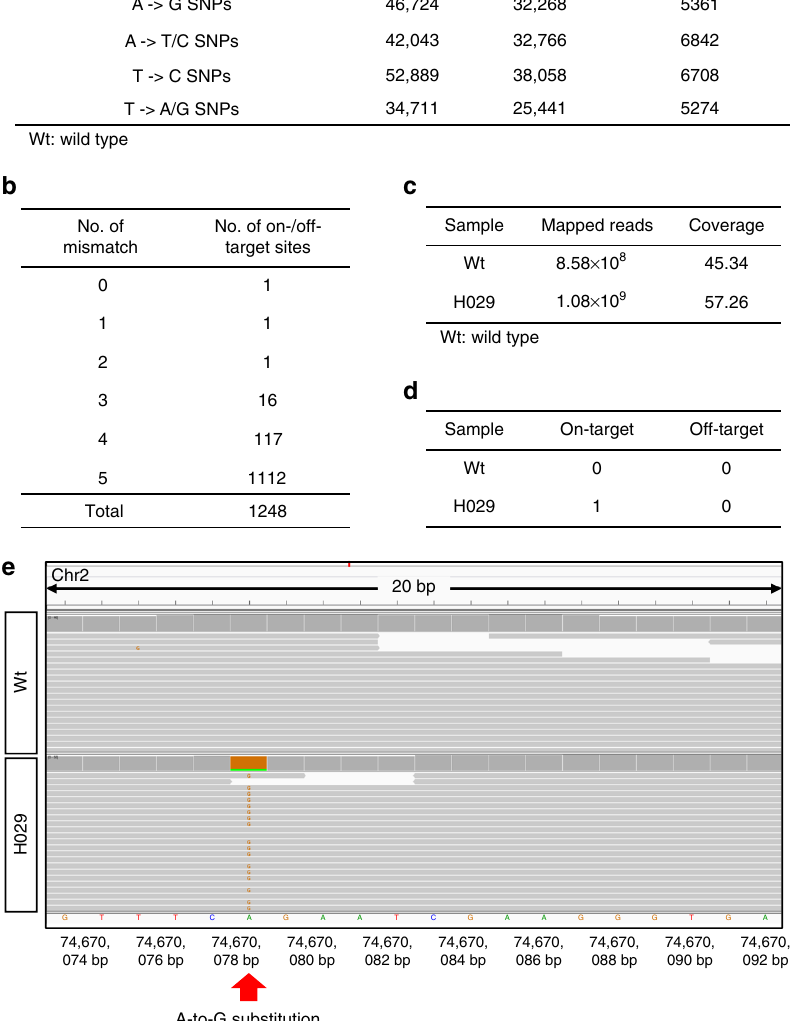
tool (http://www.rgenome.net/cas-of fi nder/) to fi nd 20, 19, and 18 potential off-target sites in the genome with up to 3- nucleotide mismatches for sgAr-1/sgAr-15/sgHoxd13 and 42 (up to 4-nucleotide mismatches) for sgTyr 20 . We randomly chose 11, 12, 10, and 11 potential off-target sites for sgAr-1, sgAr-15, sgHoxd13, and sgTyr, respectively (Supplementary Fig. 7a – d). These sites were sequenced using tail DNA from